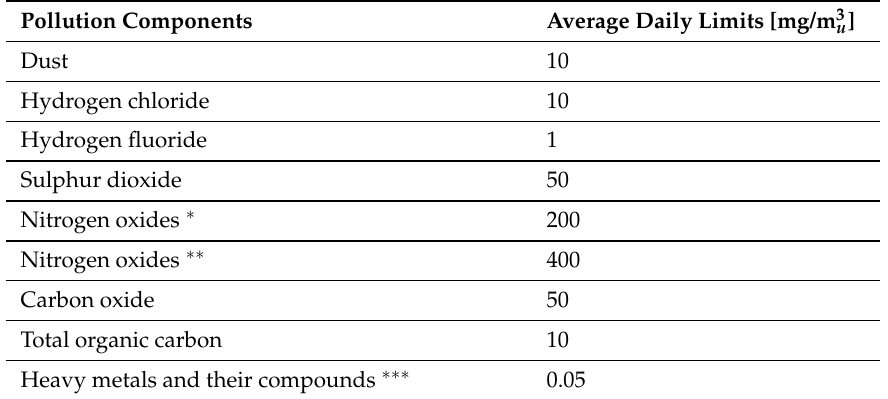
Table 3. Emission standards for installations for the thermal treatment of municipal